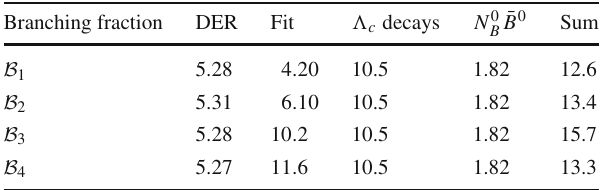
Table 1 Relative systematic uncertainties (%) in the branching frac- tion measurements. Here, B 1 ≡ B ( ¯ B 0 → ¯ K 0 (cid:4) + c ¯ (cid:4) − c ) , B 2 ≡ B ( ¯ B